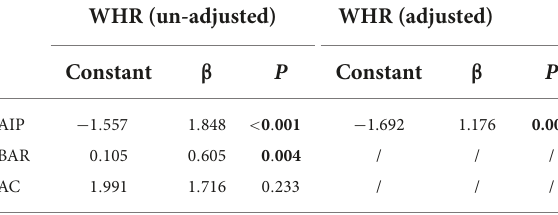
TABLE 4 Independent correlation analysis of cardiovascular risk predictors with